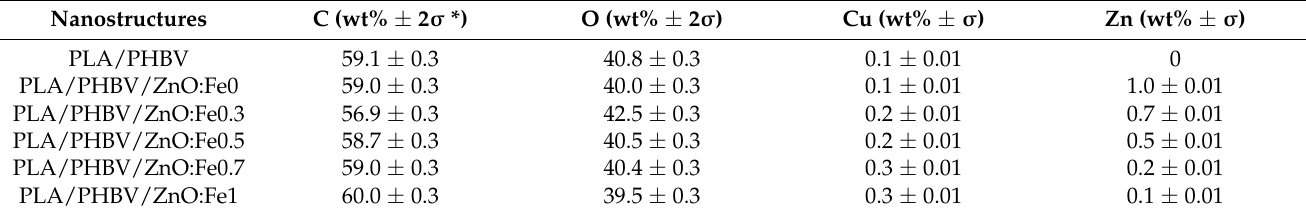
Table 2. Elemental chemical composition of PLA/PHBV/ZnO:Fex nanostructures determined from EDX analysis. Nanostructures